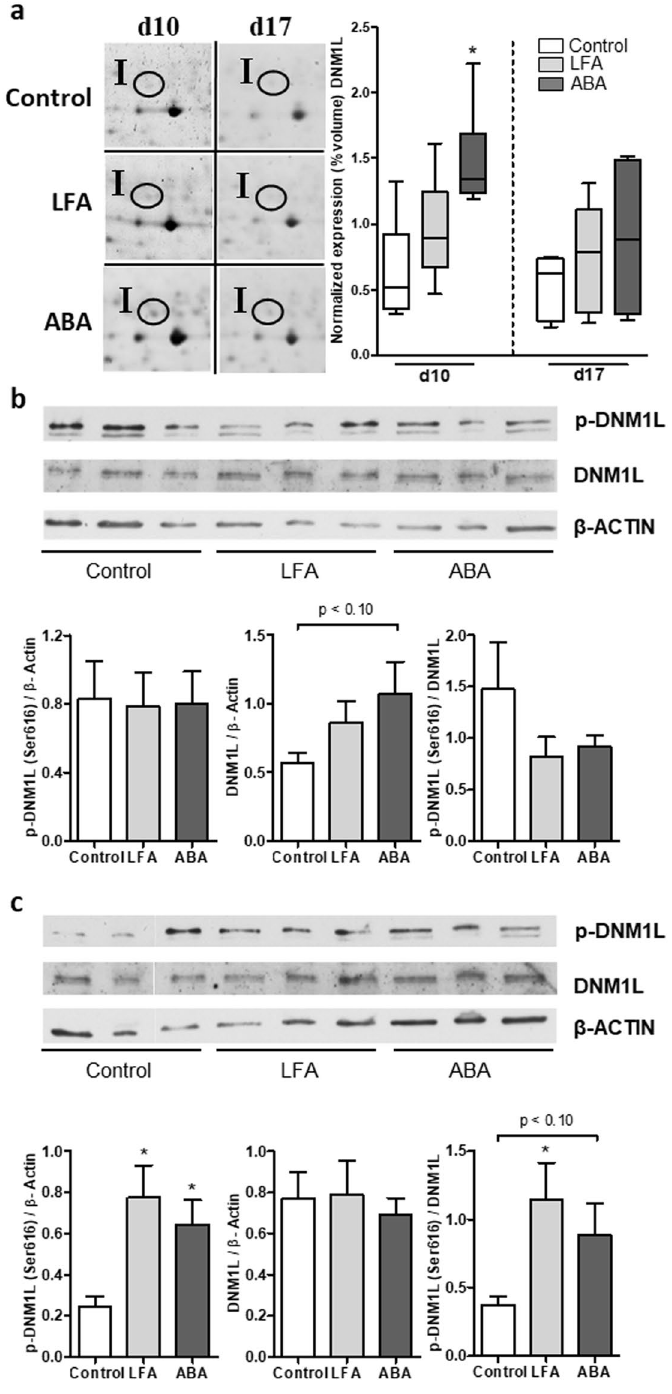
Figure 6. DNM1L hypothalamic expression. ( a ) Representative enlargements of silver-stained 2-dimensional gels (from n = 1/group) and proteomic expression profile for DNM1L protein at d10 and d17 in Control, LFA and ABA mice (n = 6/group at each time). * p < 0.05 vs Control. ( b , c ) Representative immunoblots (from 3 individuals/group) and densitometric analysis of phosphorylated-DNM1L at Ser 616 , total DNM1L, and β -actin at d10 ( b ) and d17 ( c ) (n = 6/group at each